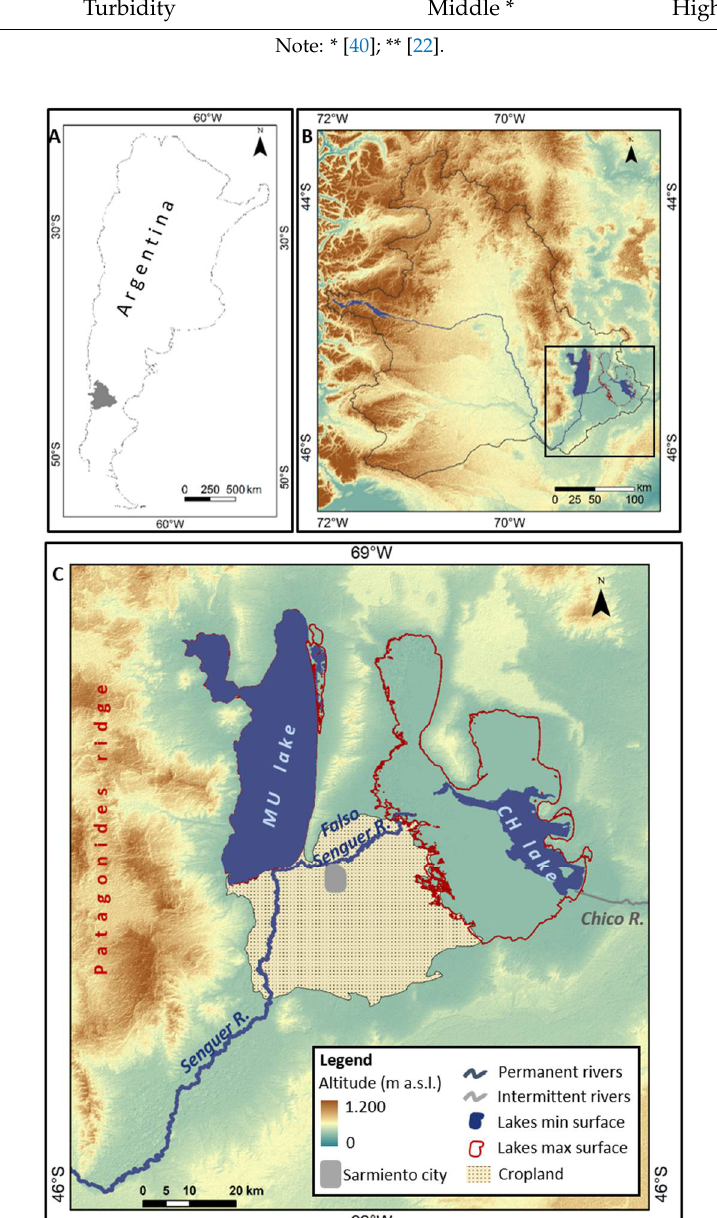
Figure 1. The study area. ( A ) Location of the Senguer River basin; ( B ) Location of the Musters and Colhué Huapí lakes; and ( C ) Musters and Colhué Huapí lakes. High elevations (900 m) on the western, northern and central east coasts of Musters Lake and slight elevation on Colhué Huapí shores. Maximum (red) and minimum (blue) lakes area extension obtained with Landsat images for the period 2001–2016 [22].